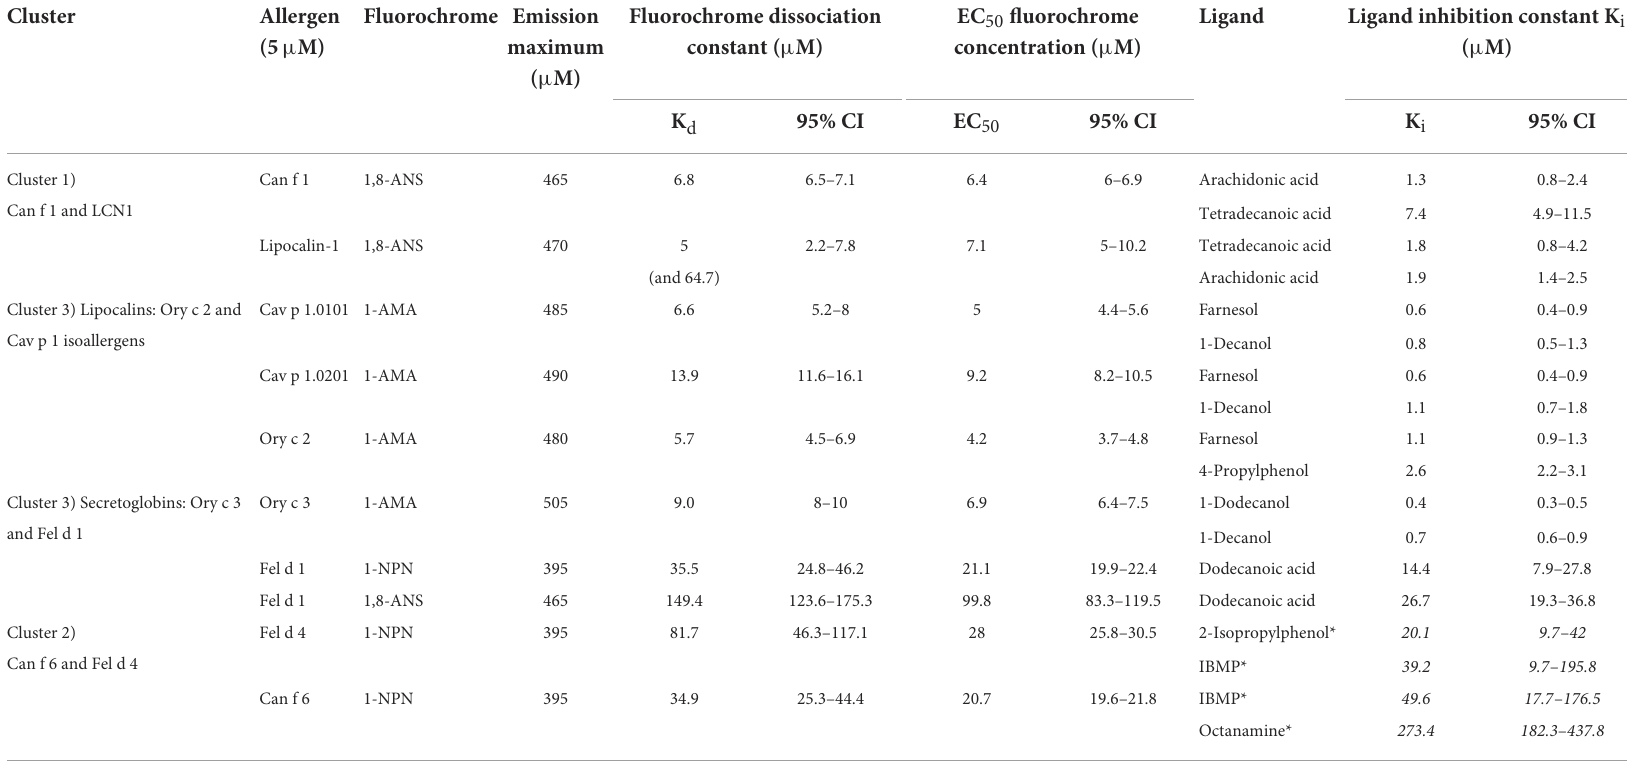
TABLE 2 Summary of fluorescence-quenching assay parameters and dissociation constants of fluorochromes and the two strongest binding ligands for eight mammalian respiratory allergens and human